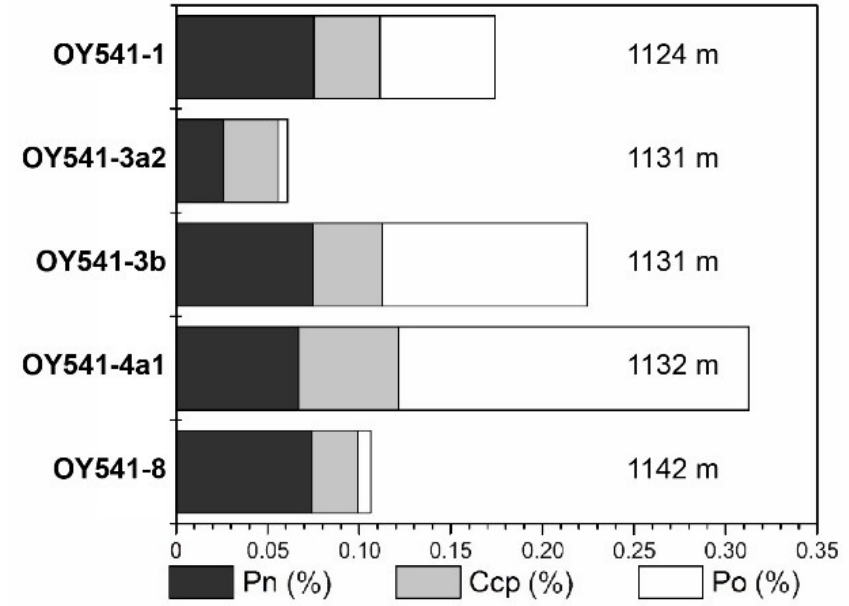
Figure 10. Calculated change of the base-metal sulphide content down-hole (data from Table 7).